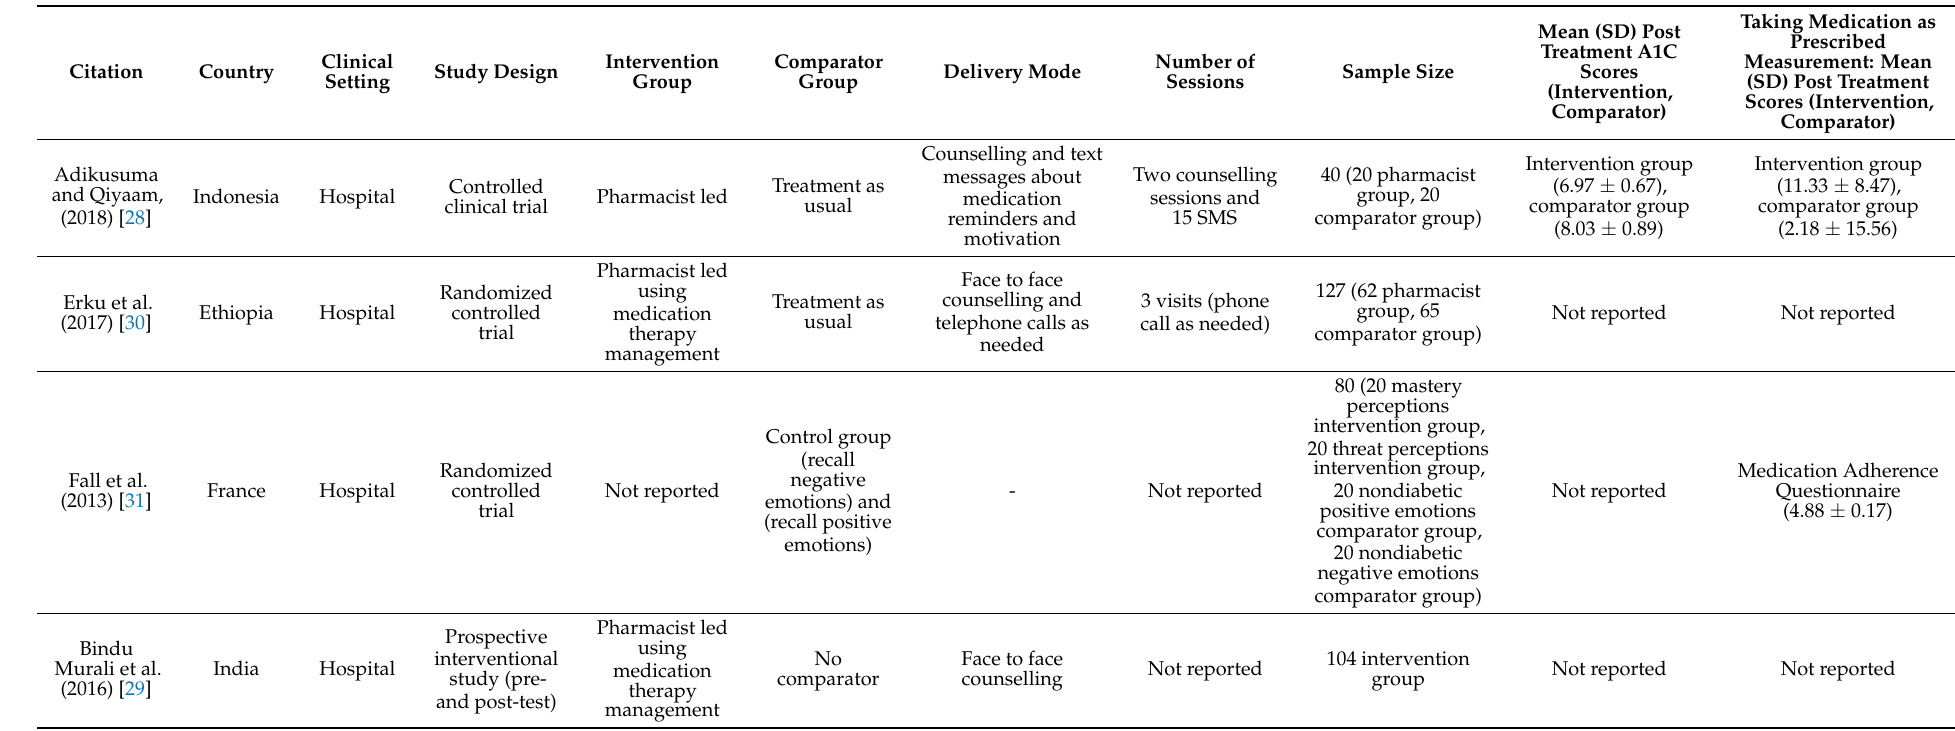
Table 1. Characteristics of the relevant